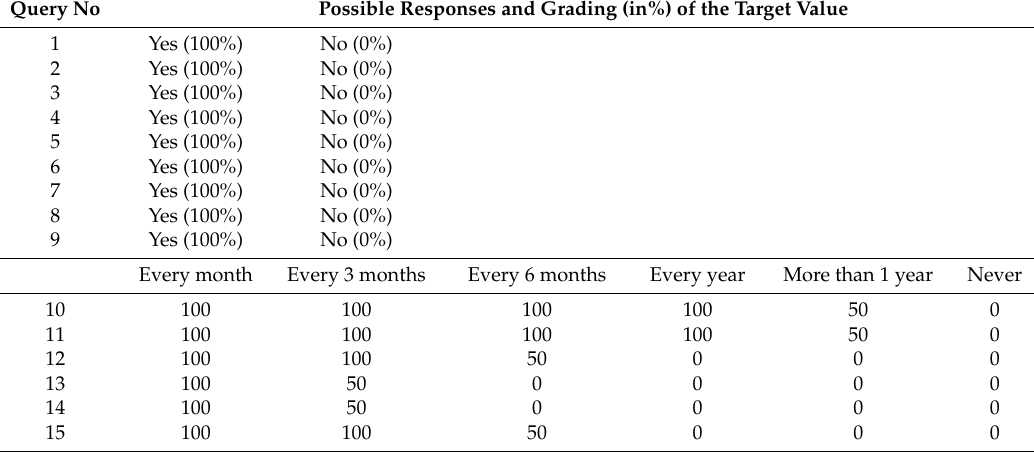
Table A2. Gap analysis queries on Monitoring Practices are presented in the same sequence as presented in Table 2 along with the grading of each query in percentage (%) depending on possible answers. The final grading is the sum of the grades of all available answer